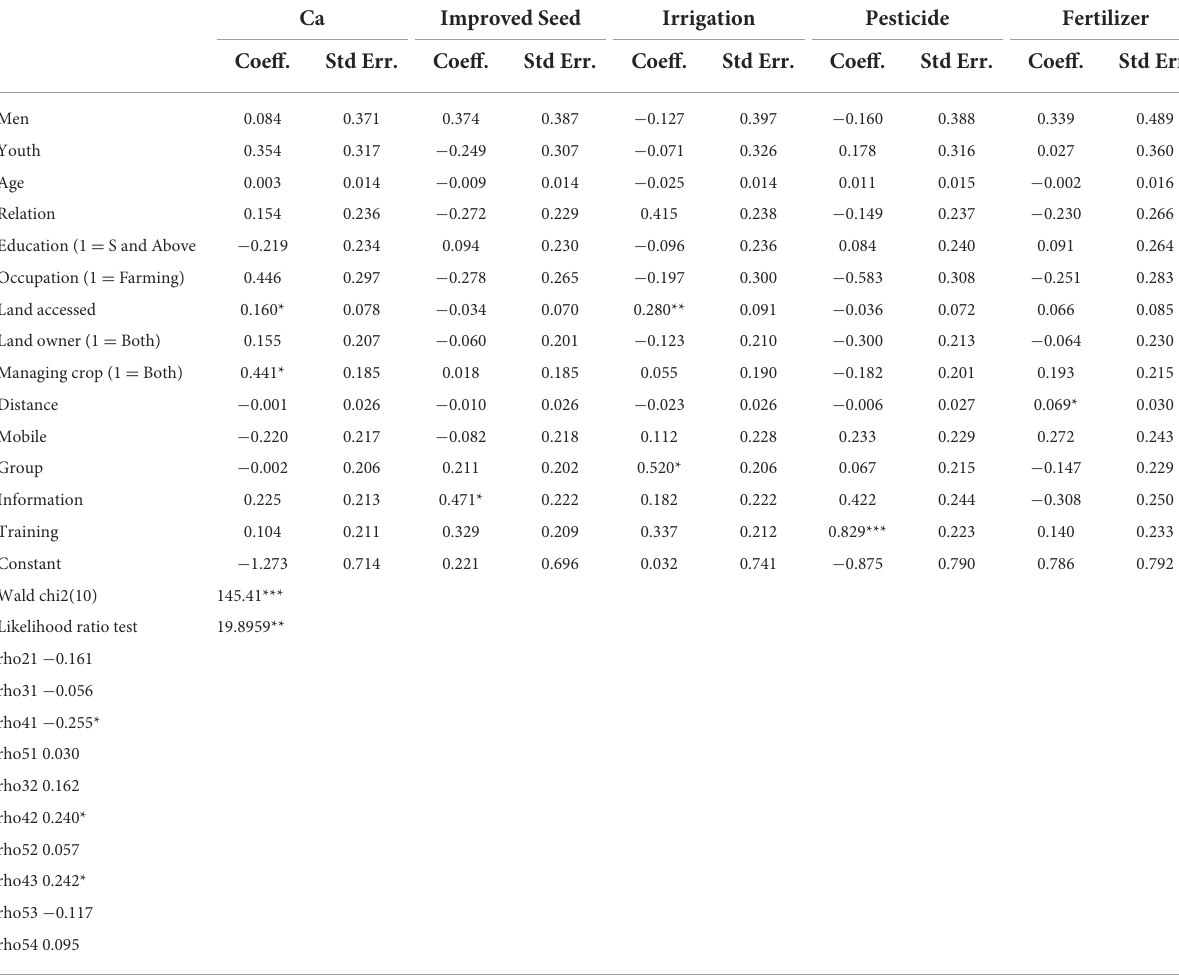
TABLE 7 Multivariate probit coefficient estimates of determinants of farmers’ use of climate-smart technologies and practices. Ca Improved Seed Irrigation Pesticide Fertilizer Coeff. Std Err. Coeff. Std Err. Coeff. Std Err. Coeff. Std Err. Coeff. Std